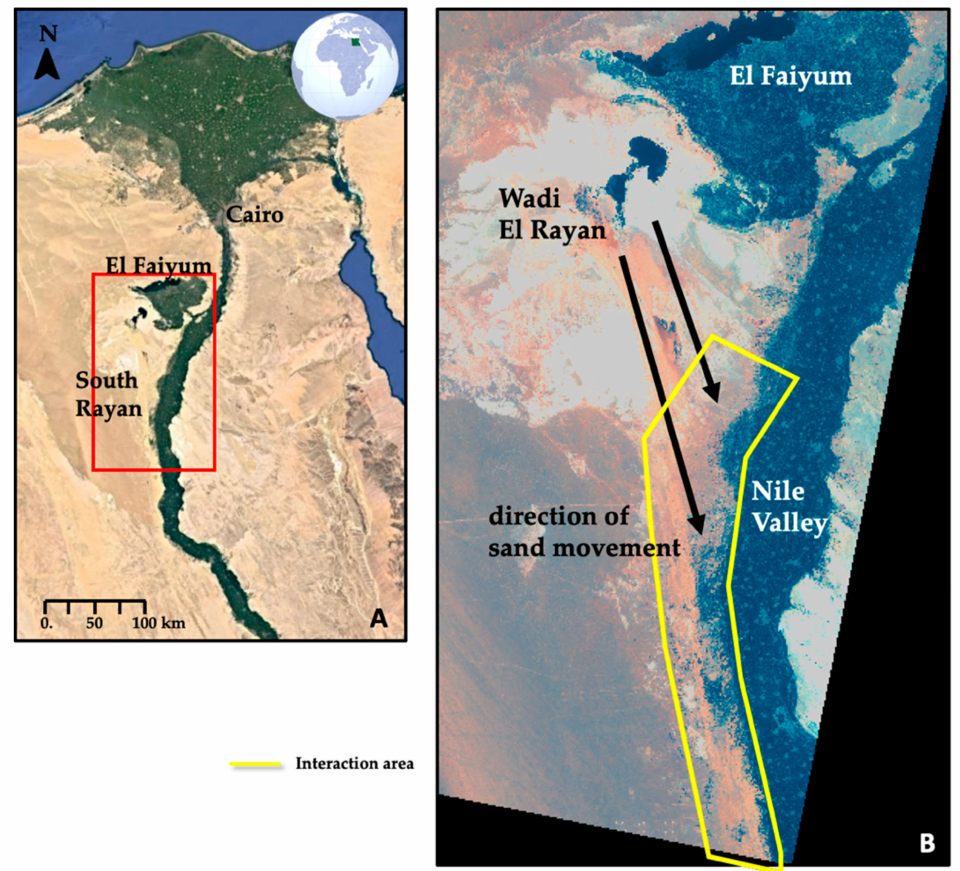
Figure 1. ( A ) Google Earth image of Egypt indicating the location of ( B ) within the red rectangle. ( B ) False-color Landsat 8 OLITIRS image over the South-Rayan dune field and the direction of sand dune movement (source [29]), indicating the interaction area within the yellow